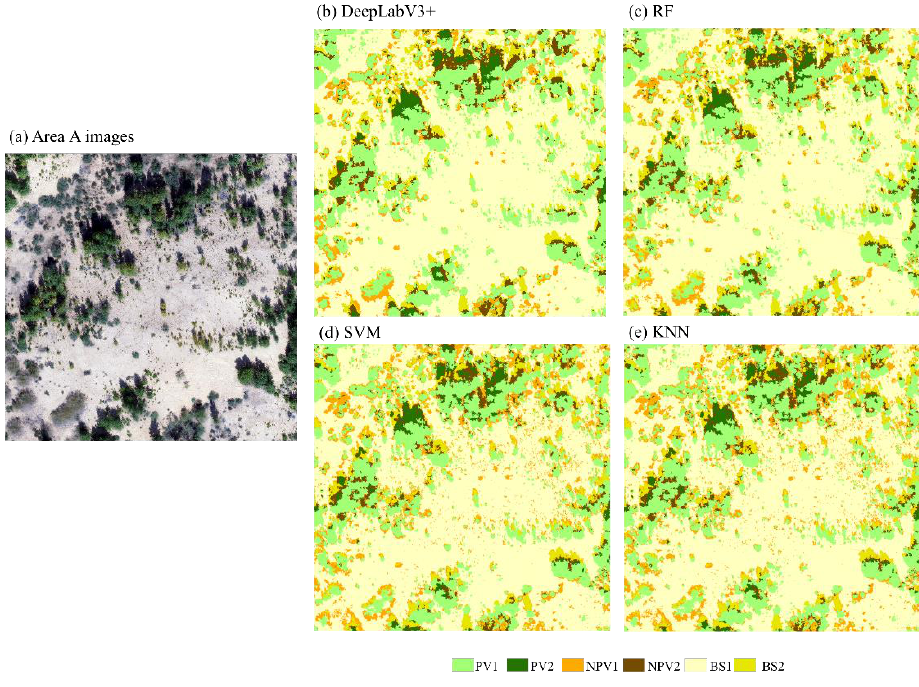
Figure 7. Identification results of the deep learning and machine learning methods. ( a ) Original images; ( b ) Estimation results by DeepLabV3+; ( c ) Estimation results by RF; ( d ) Estimation results by SVM; ( e ) Estimation results by KNN. Table 3. Comparison of deep learning and machine learning methods for object classification accuracy at all